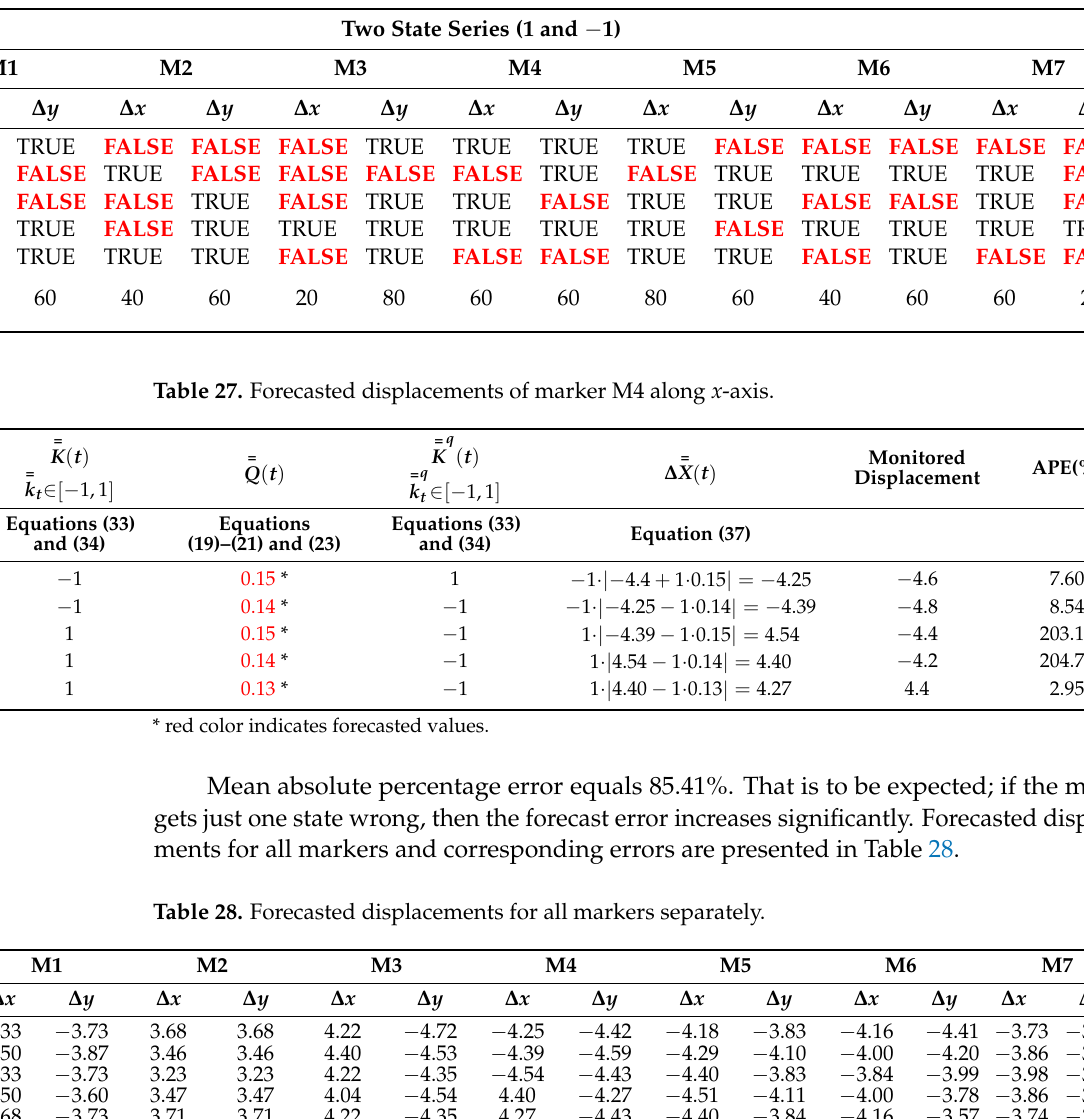
Table 26. Accuracy of AR(10) model for all markers separately forecasted the first difference.